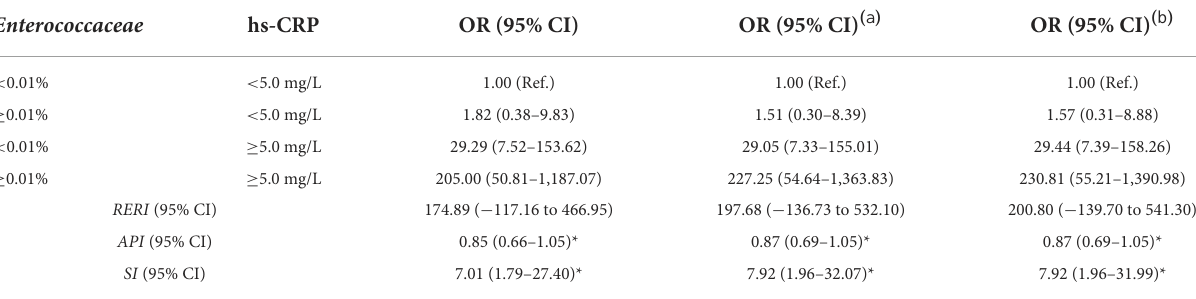
TABLE 4 Additive interaction analysis between hs-CRP and family Enterococcaceae for first-ever ischemic